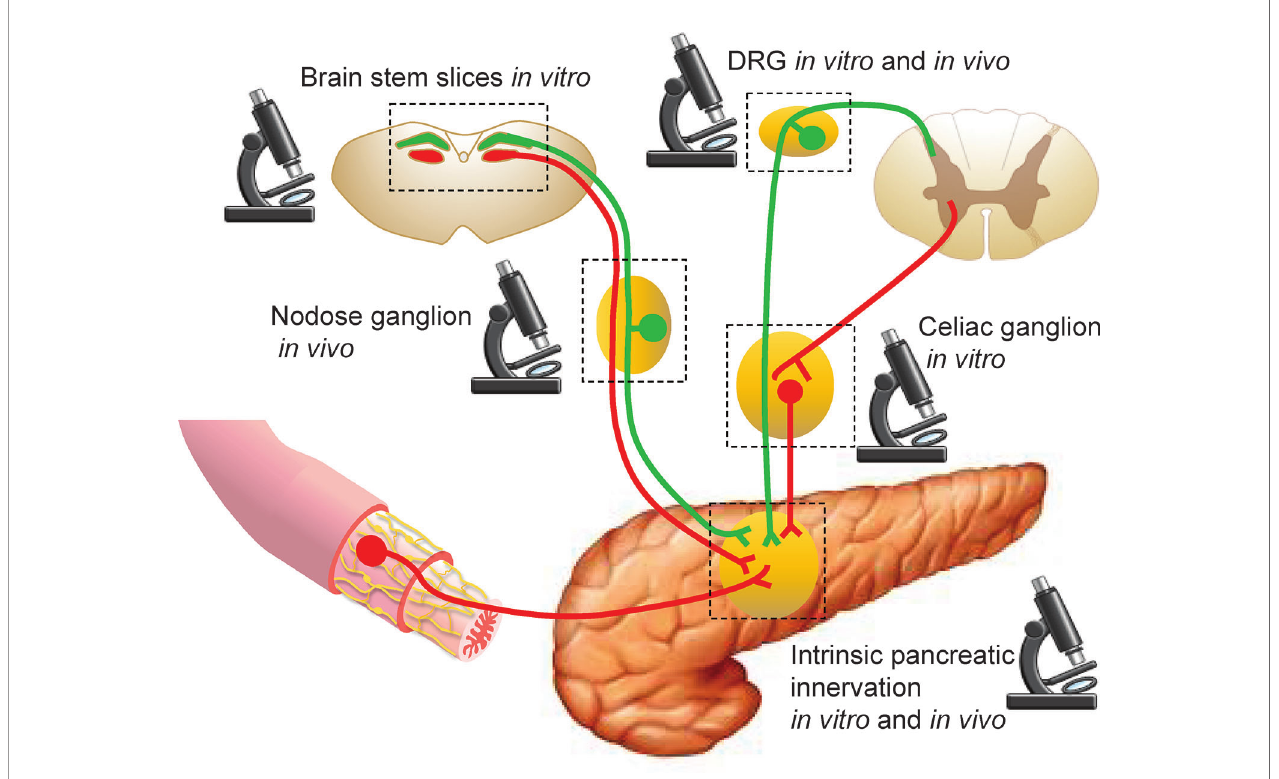
FIGURE 1 | Sites for imaging pancreatic innervation. Schematic representation of extrinsic sources of pancreatic innervation that converge on intrinsic pancreatic ganglia. Microscope icons indicate imaging